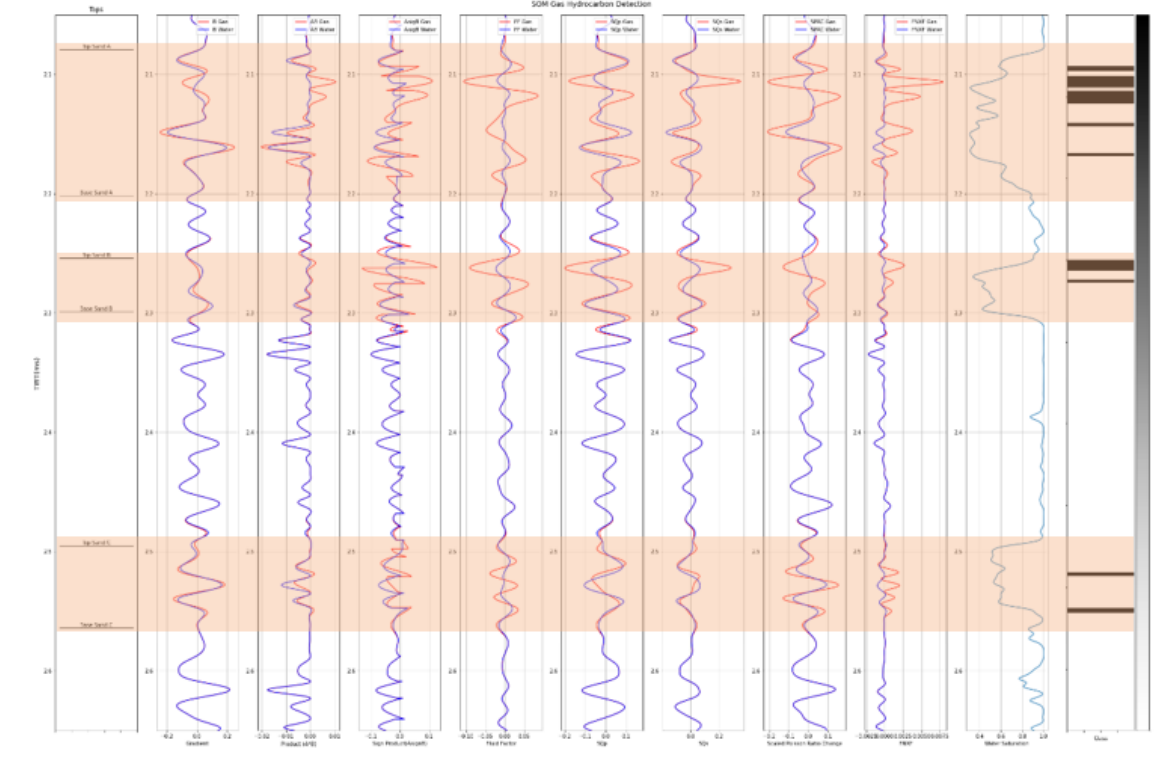
Figure 10. Hydrocarbon delineation result on gas condition.